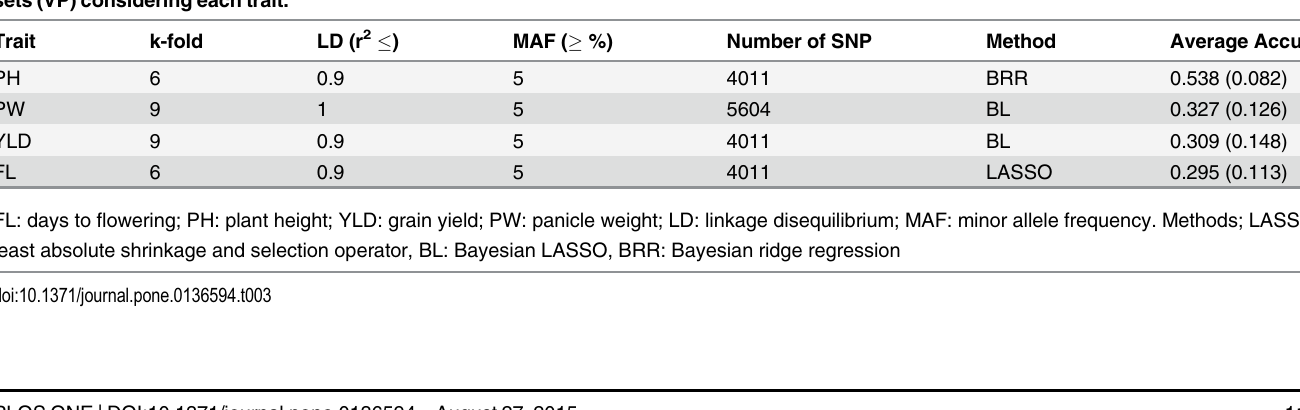
Pairwise genetic differentiation evaluated by F ST parameter was low but significant ( p < 0.01) between all pairs of subpopulations (Table 2). Genotypic data had a higher power of discrimi- nation than phenotypic data. As a result, the genotypic structure only partially overlapped the phenotypic structure. The existence of this genotypic structure provided a basis for evaluating the effect of the genetic distance between the training and validation populations on the accu- racy of GEBVs.